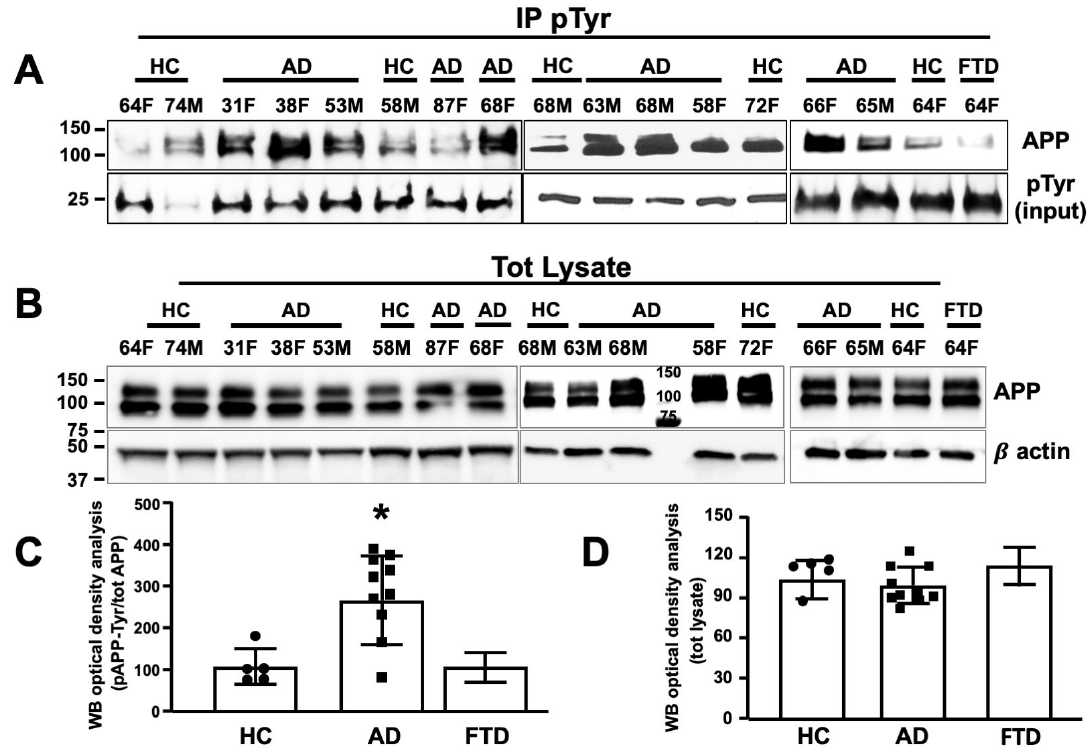
Figure 5. The amyloid precursor protein was phosphorylated at the Tyr residue in neurons from AD patients. ( A ) After 5 weeks in di ff erentiating media, neurons from healthy controls (HC) and AD patients and FTD patients were processed for pTyr IP using mouse anti-pTyr magnetic beads- conjugated antibody (4G10) and analyzed by WB using rabbit anti-APP antibody (Y188). Membranes were blotted with anti-mouse IgG and the pTyr band (input) migrating at 25 kDa was used as loading control. ( B ) WB analysis of basal APP levels using the rabbit anti-APP antibody (Y188). β -actin was used as a loading control. ( C , D ) Densitometric analysis of pAPP-Tyr levels in AD patients vs. HC ( C ) and total APP levels expressed as a percentage of HC ( D ). Mean optical density values were calculated as the ratio of pAPP-Tyr levels relative to basal APP levels (after normalization to β -actin) from each sample (experiments from each sample were repeated three times, n = 3). Statistically significant di ff erences were calculated using Student’s t-test. * p < 0.05, vs. HC. 3.5. Fyn TK Activity Was Increased in Neurons from AD Patients as Compared to Healthy Volunteers Neurons from AD patients and healthy volunteers were also processed for the determination